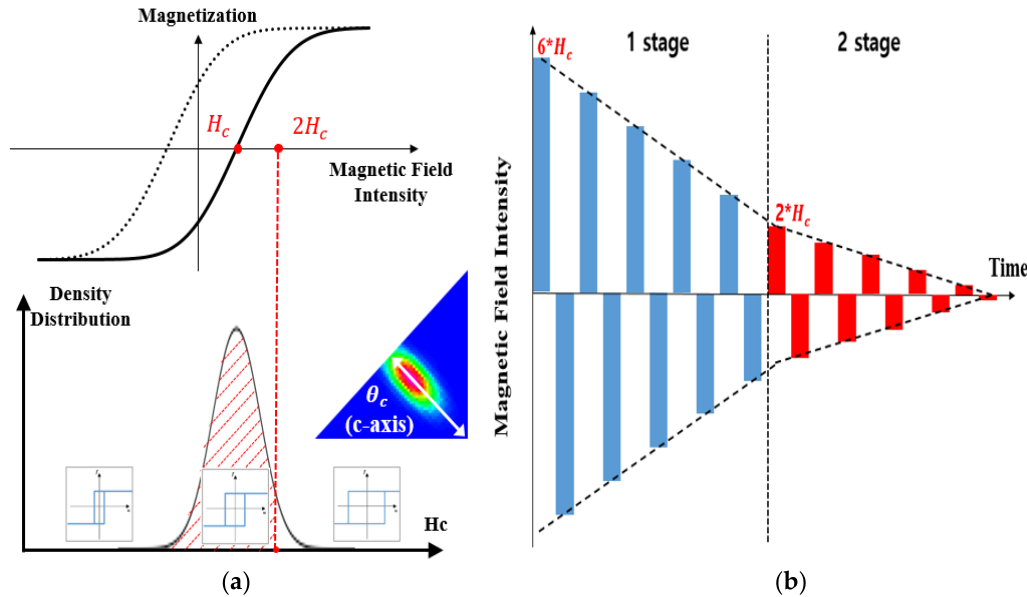
Figure 4. Process used to determine the proposed protocol: ( a ) the process; ( b ) schematic view of the proposed protocol.